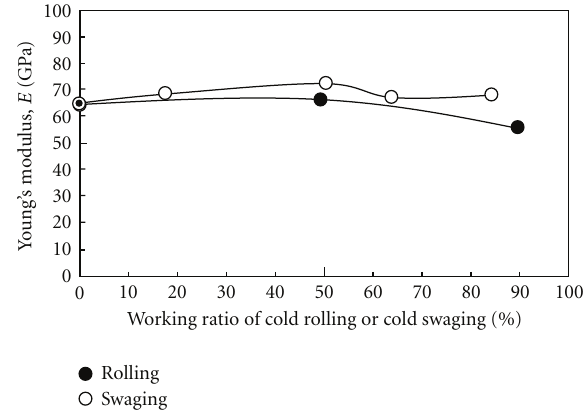
Figure 2: Young’s modulus of TNTZ subjected to cold rolling or cold swaging as a function of working